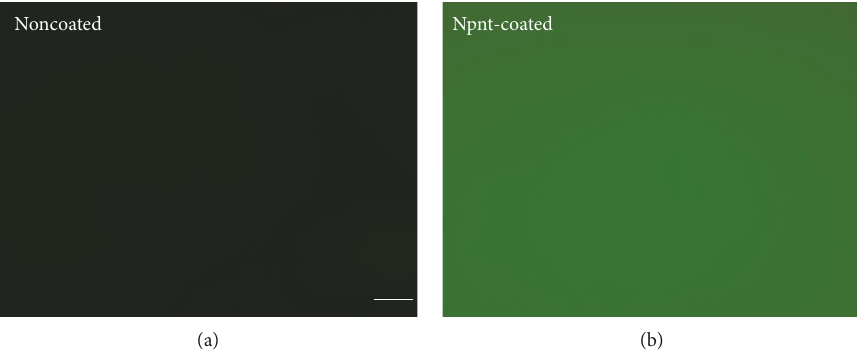
Figure 1: Fluorescence visualization of coated Npnt. Npnt-coated polystyrene was positive for anti-Npnt (b). No fl uorescence was observed in the noncoated control (a) (scale bar: 50 μ